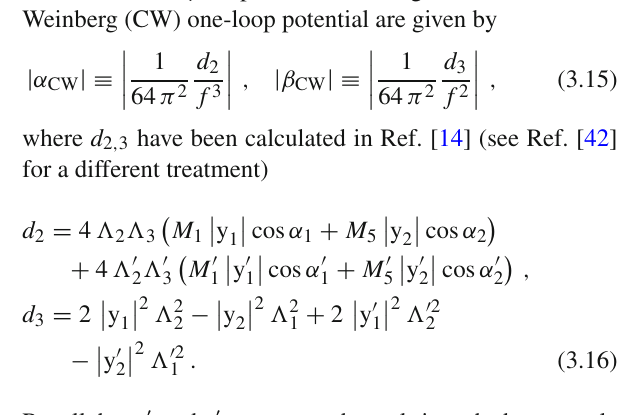
Table 4 In the upper panel, four different sets of input parameters are shown as examples. In all cases, m σ = 1 . 5 TeV, sin 2 γ = 0 . 08 and α (cid:6) = 0. The corresponding imaginary parts of the Wilson coeffi- 1 , 2 cients, effective coefficients ˜ κ h ,σ t and the electron EDM are collected in